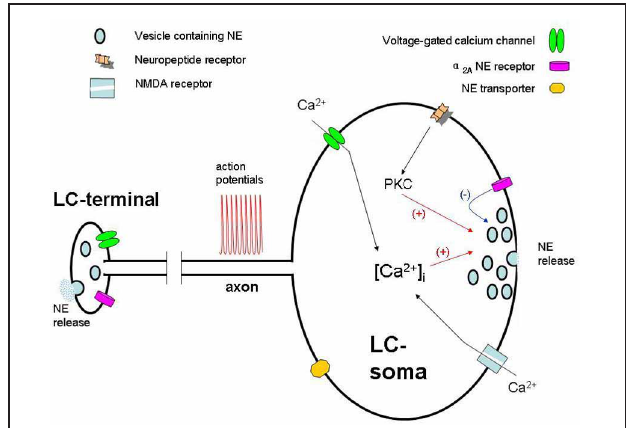
FIGURE 1 | Schematic representation of physiology of quantal NE release from somatodendritic sites and terminal in a locus coeruleus neuron. Action potentials elevate intracellular Ca 2 + ([Ca 2 + i ]) and the release of NE from the somatodendritic sites of LC neurons. NE, through the activation of local α 2A -adrenoceptors, inhibits LC neurons. Neuropeptides (i.e., hypocretin) may, via activation of their receptors and PKC, alter NMDA-induced elevation of [Ca 2 + ] i , which in turn modulates somatodendritic